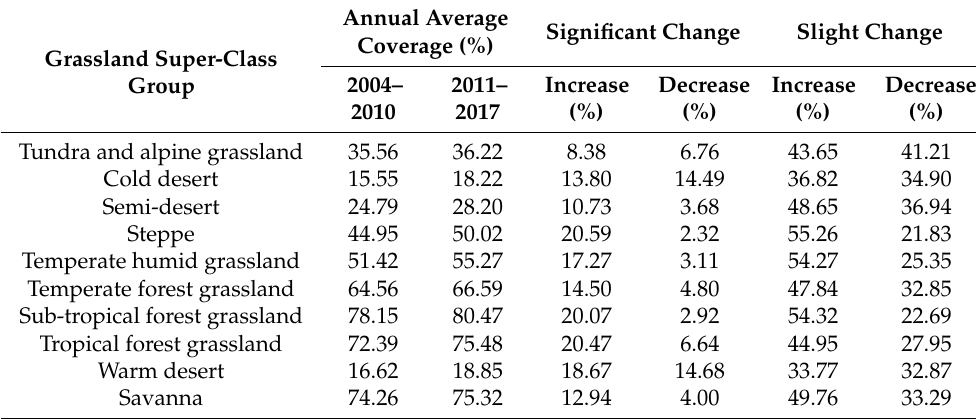
Table A4. The statistical description of grassland coverage in China before (2004–2010) and after (2011–2017) the implementation of the SISGC.